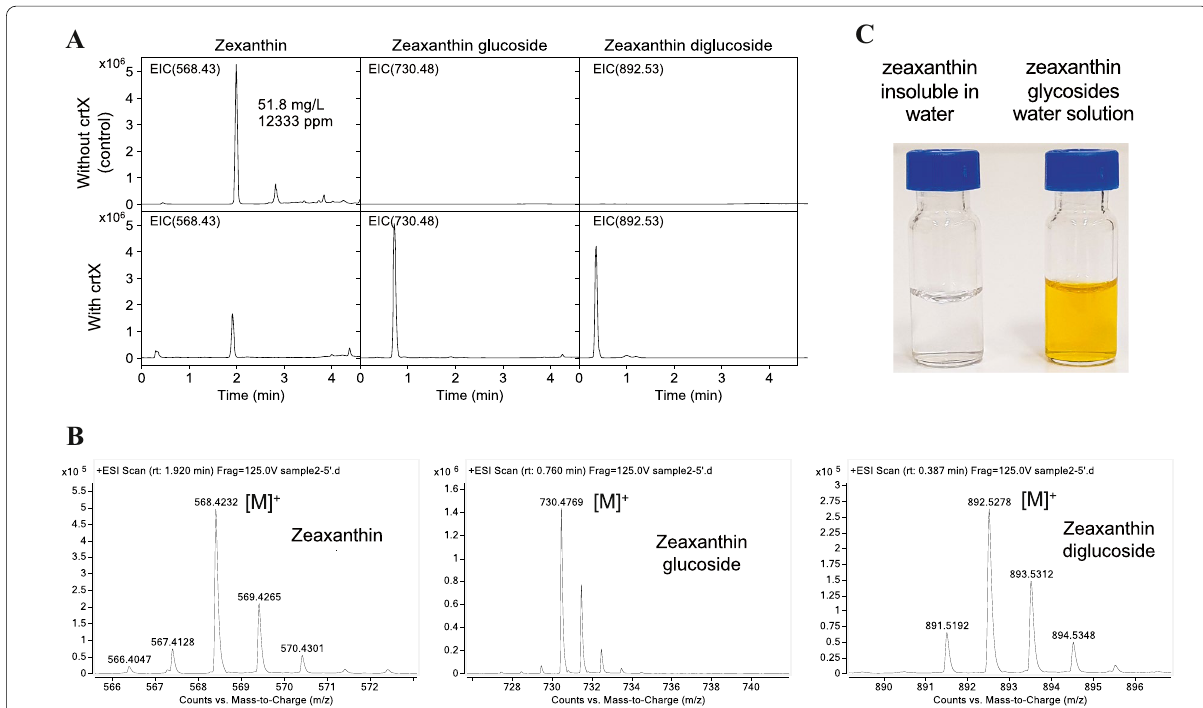
Fig. 2 Production of zeaxanthin glucosides. A LC/MS chromatograms of zeaxanthin strains with and without the expression of crtX . B Mass spectra of zeaxanthin and its glucosides. C The water solutions of zeaxanthin and zeaxanthin